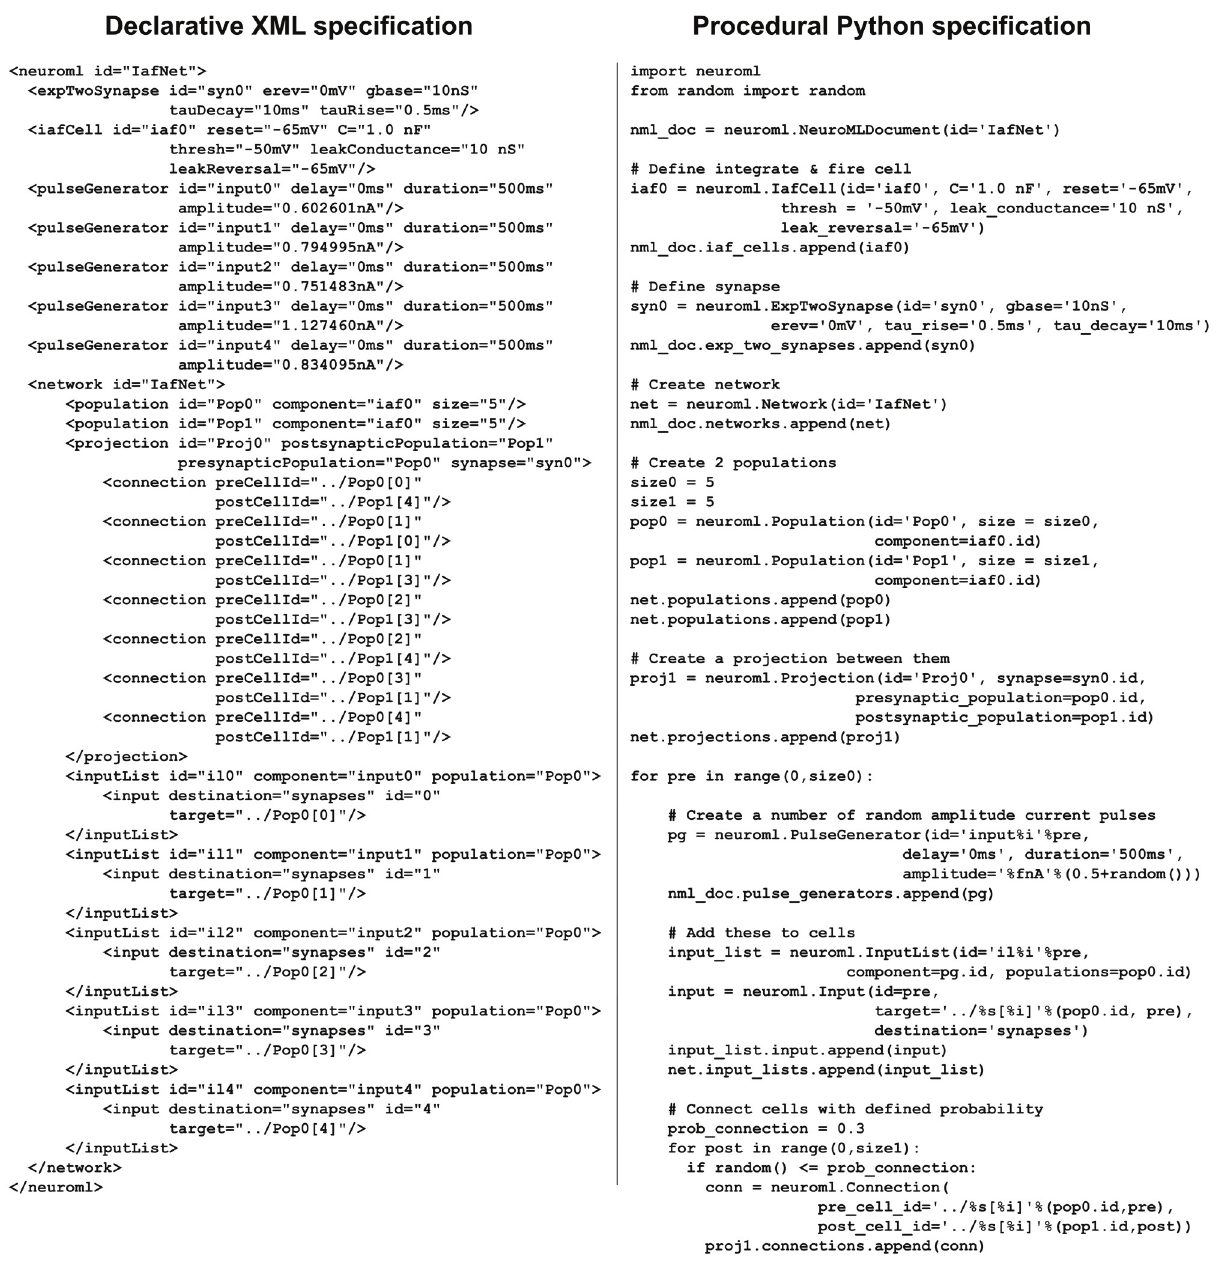
parameters, along with a prototype synapse based on expTwoSynapse . A projection is created between the two populations and for each cell in the presynaptic population, an input current is applied, and connections are made to the postsynaptic cells with probability 0.3. The XML on the left is an example of one network instance which can be generated from this